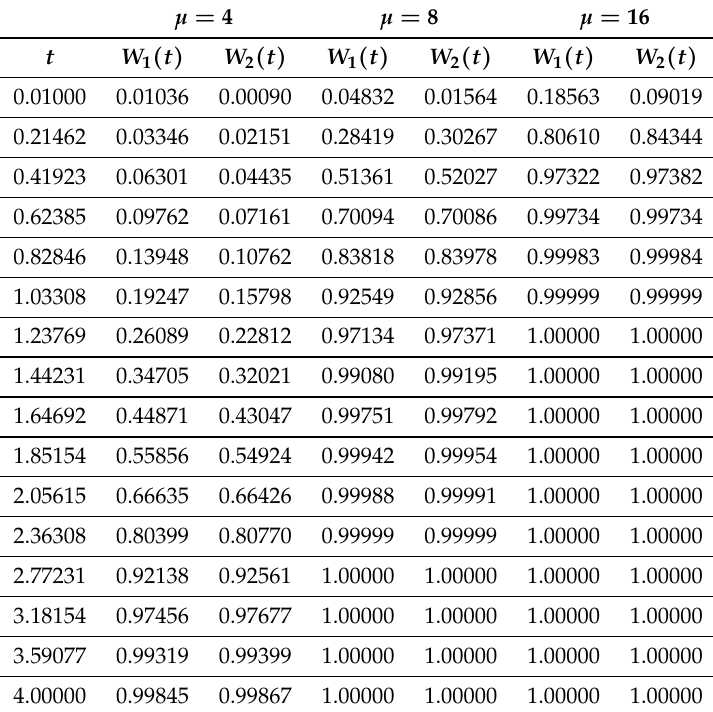
Table 2. Distribution functions W 1 ( t ) and W 2 ( t ) .